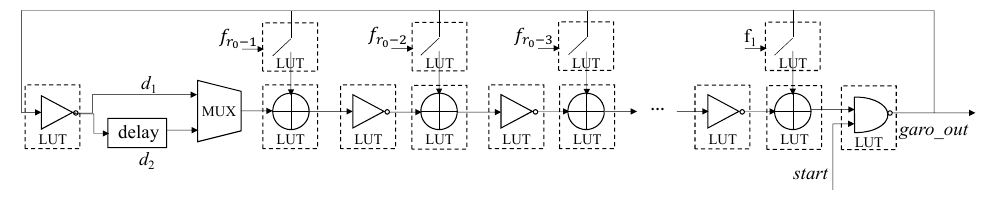
Figure 21: The implementation of the test